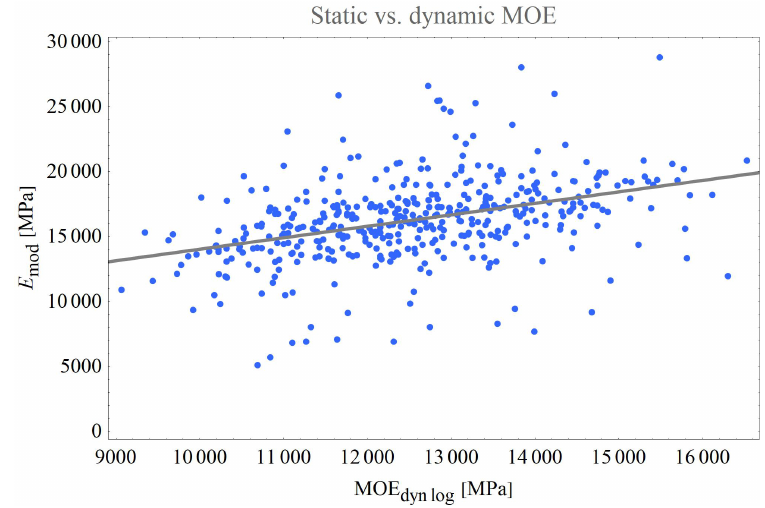
Figure 16. Comparison of static MOE from tension tests and dynamic MOE of logs.